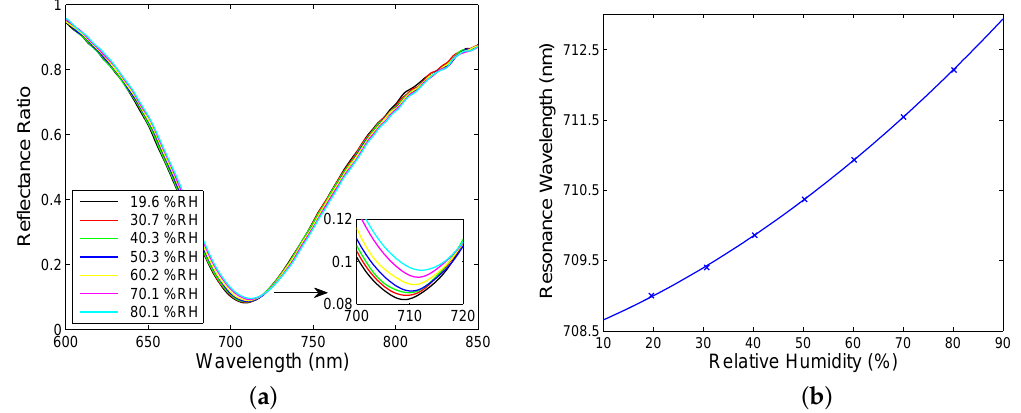
Figure 8. Spectral reflectance ratio R p ( λ ) / R s ( λ ) for different values of the RH of moist air measured for the MPS ( a ). Resonance wavelength as a function of the RH of moist air with a polynomial fit ( b